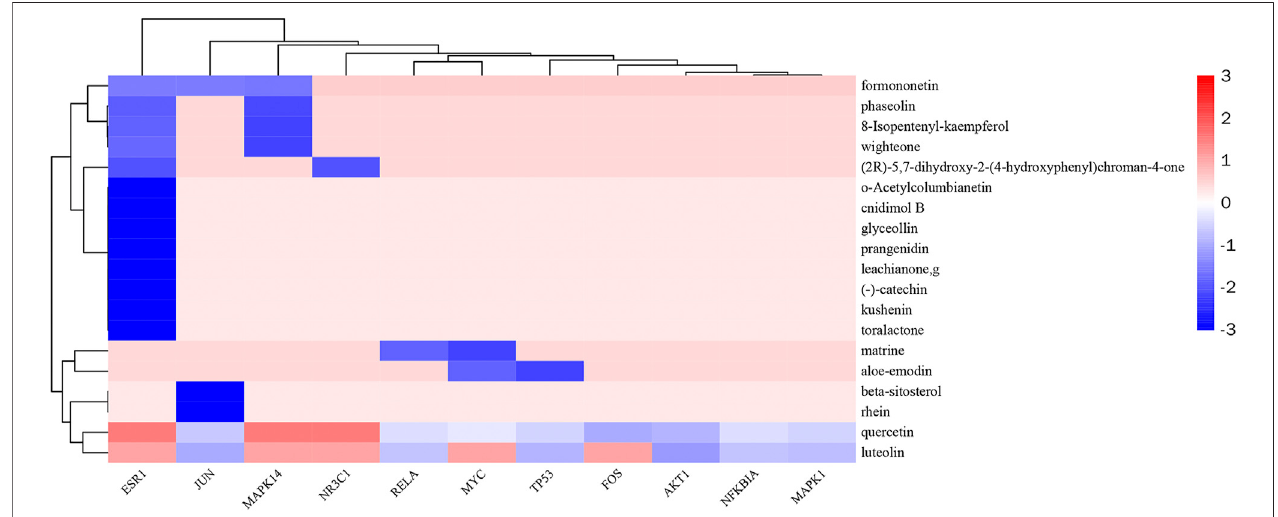
FIGURE 5 | Heatmap of docking af fi nity of hub